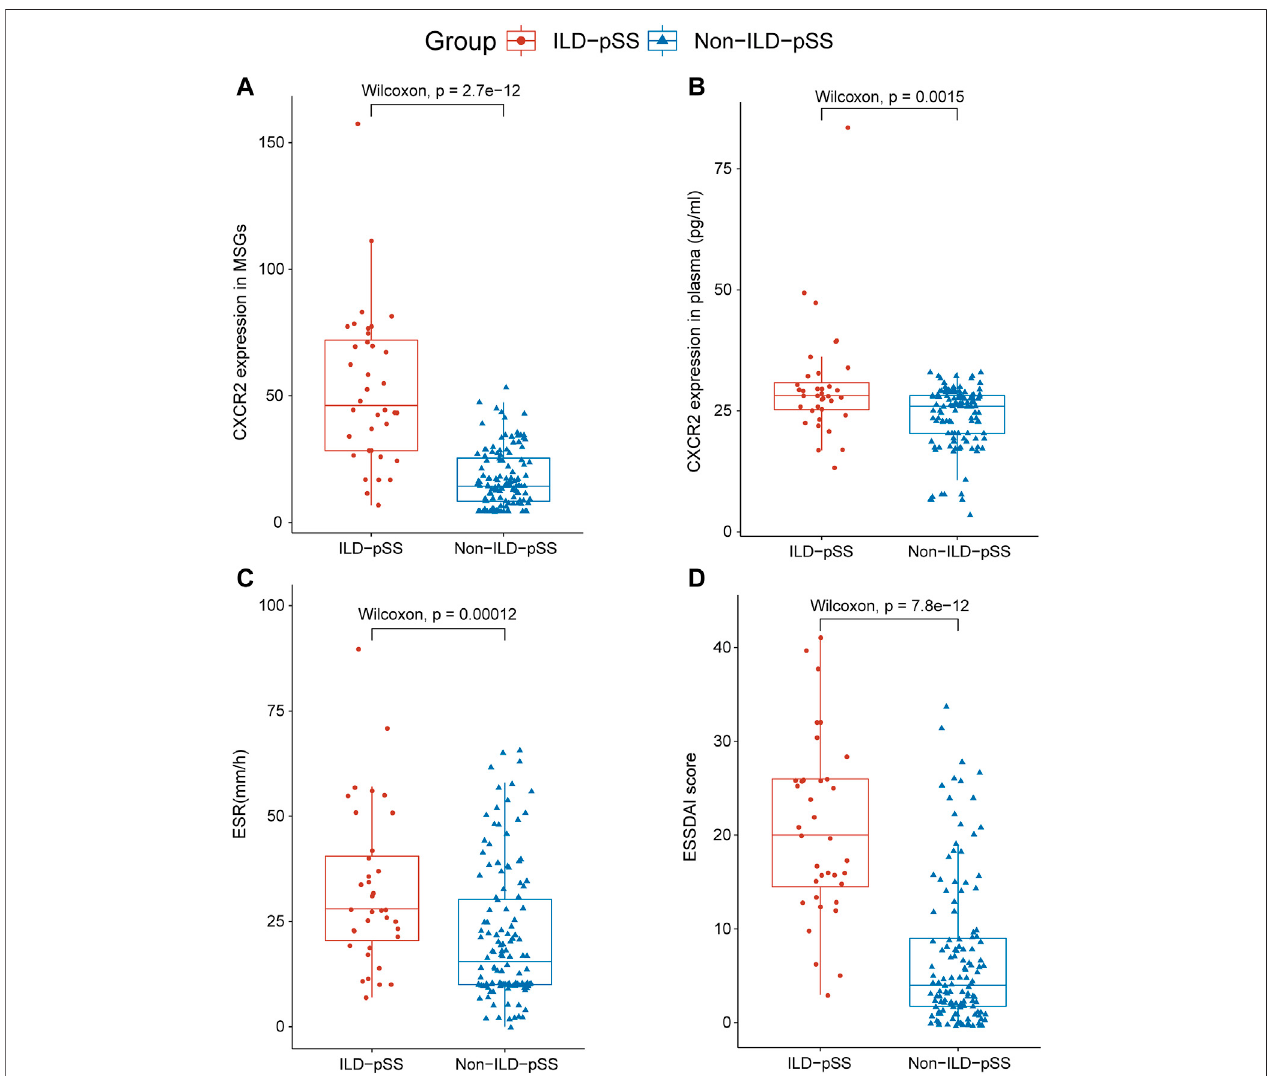
FIGURE 1 | Analysis of CXCR2 and IL-8 expression and clinical parameters in patients with ILD-pSS and non- ILD-pSS. CXCR2 gene expression by RNA sequencing (A) ,CXCR2levelinplasma (B) ,ESR (C) ,andESSDAIscores (D) weresigni fi cantlyhigherinpatientswithILD-pSSvs.non-ILD-pSSpatients.Horizontallines, from bottom to top, denote the minimum, 25th percentile, median, 75th percentile, and